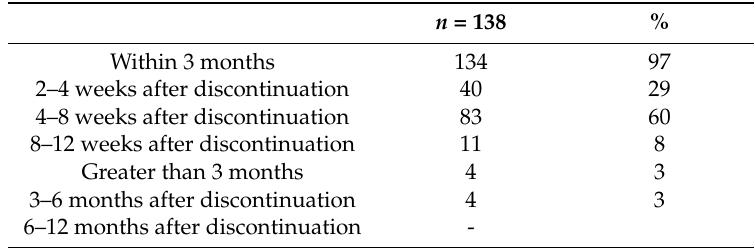
Table 3. Clinicians report of protocol timing for re-evaluation of thyroid function following treatment cessation (thyroid